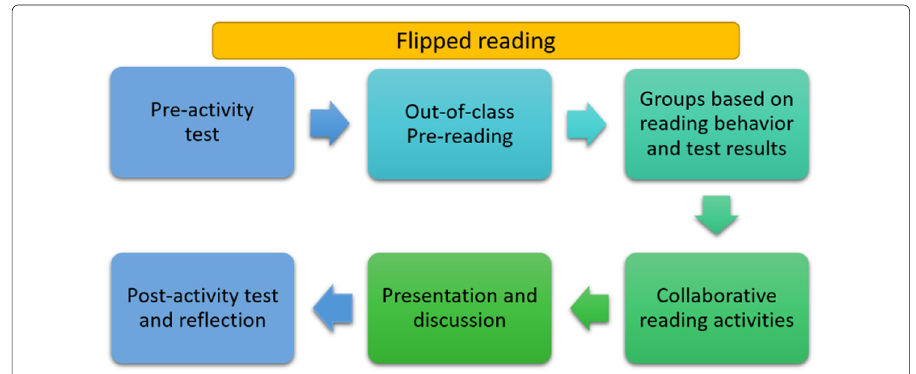
Fig. 15 Typical workflow for flipped reading